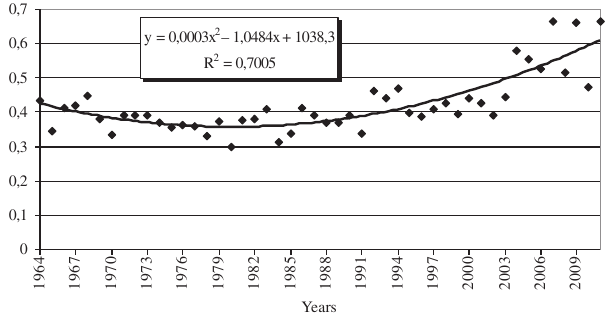
Figure 3 – The chronology of the seasonal means of atmospheric drought at Újfehértó